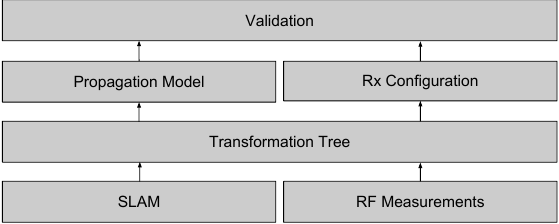
Figure 11. Overview of the validation